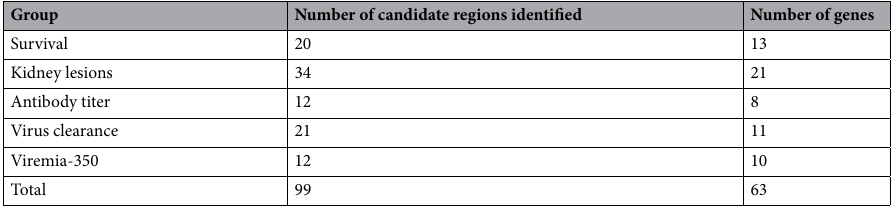
Table 2. Number of candidate regions and genes detected by overlapping Z(F ST ) and log 2 (θ π ratios ) in five differential groups of responses to AMDV-infection. Total do not consider overlap between groups.